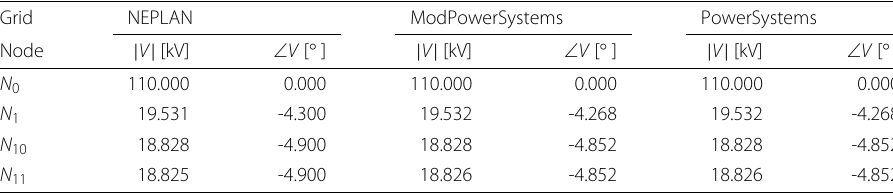
Table 3 Excerpt from the numerical results for node phase-to-phase voltage magnitude and angle regarding the medium-voltage benchmark grid Grid NEPLAN ModPowerSystems PowerSystems Node | V | [kV] ∠ V [ ◦ ] | V | [kV] ∠ V [ ◦ ] ∠ V [ ◦ ] N 0 110.000 0.000 110.000 0.000 110.000 0.000 N